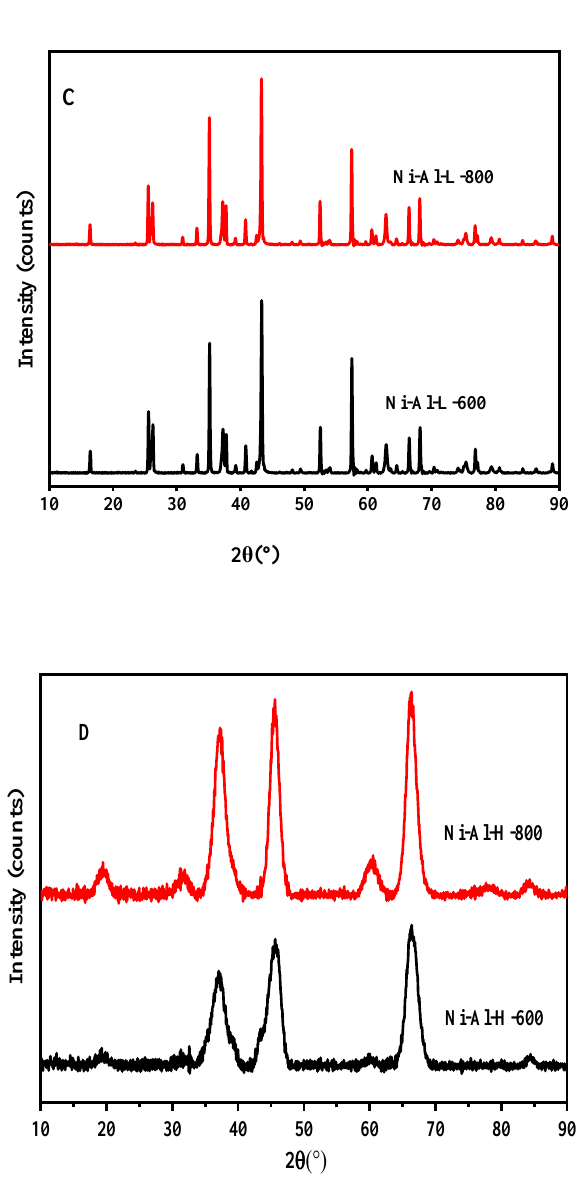
Figure 3. X-ray di ff raction patterns for ( A ) Ni-Zr –L ( B ) Ni-Zr-H ( C ) Ni-Al-L ( D ) Ni-Al-H catalysts Figure 3. X-ray diffraction patterns for (A) Ni-Zr –L (B) Ni-Zr-H (C) Ni-Al-L (D) Ni-Al-H catalysts calcined at 600 and 800 ◦ calcined at 600 and 800 °C.